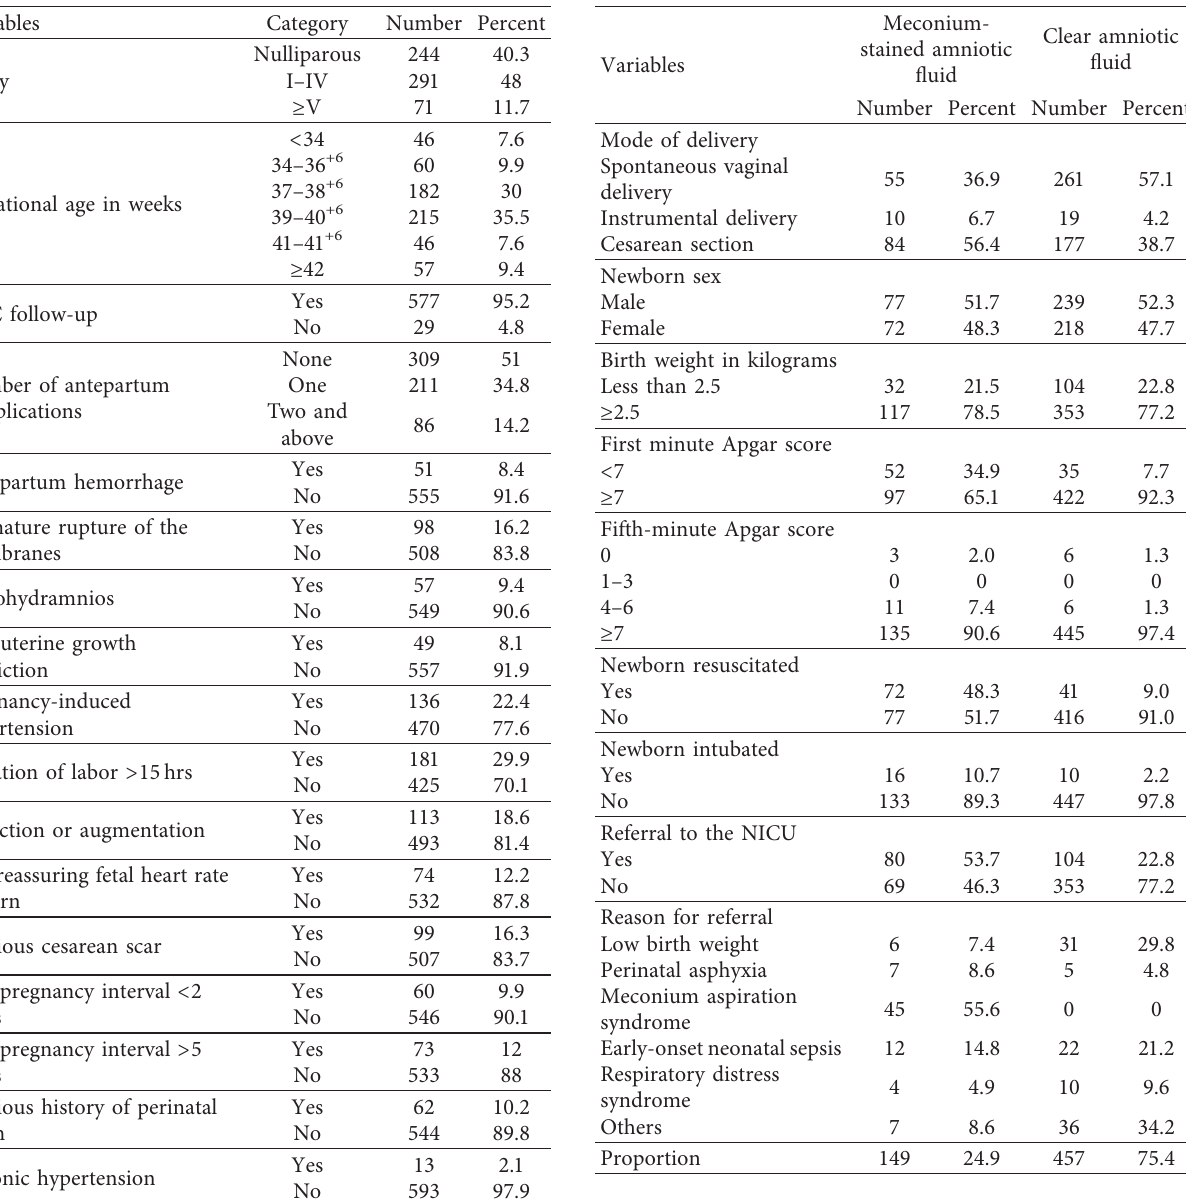
Table 2: Description of previous and current obstetrics and medical-related factors of study participants in Felege Hiwot Re- ferral Hospital, June–August 2018 (n � 606).